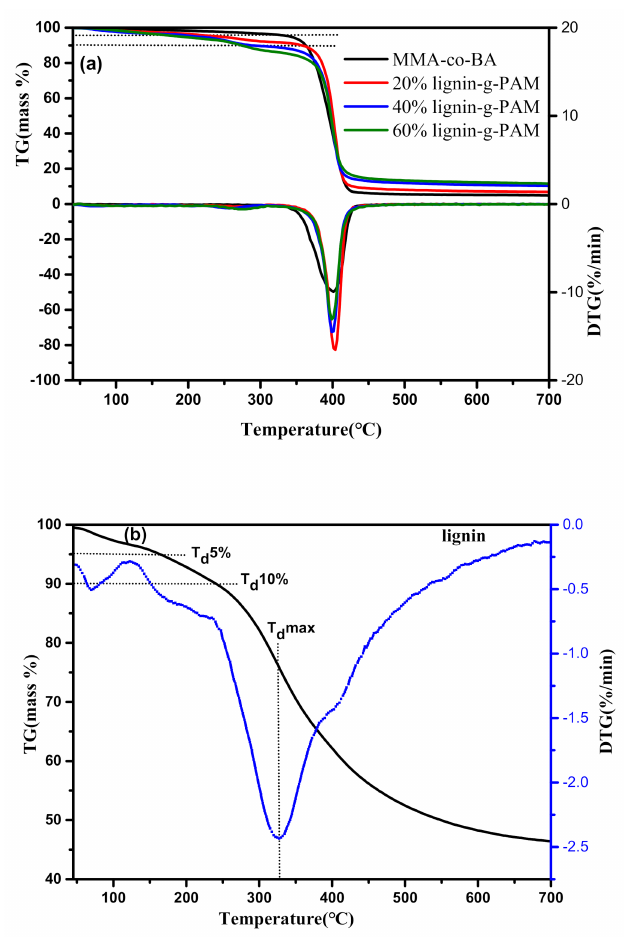
Figure 7. TG and DTG curves of the pure MMA- co -BA and lignin-based hybrid acrylic resins ( a ), and lignin ( b ). Table 2. Thermogravimetric analysis results for T d 5%, T d 10%, T d max, and carbon